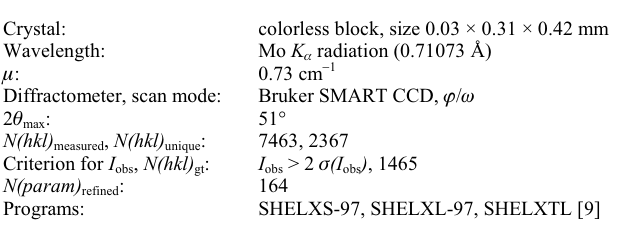
Table 1. Data collection and handling.